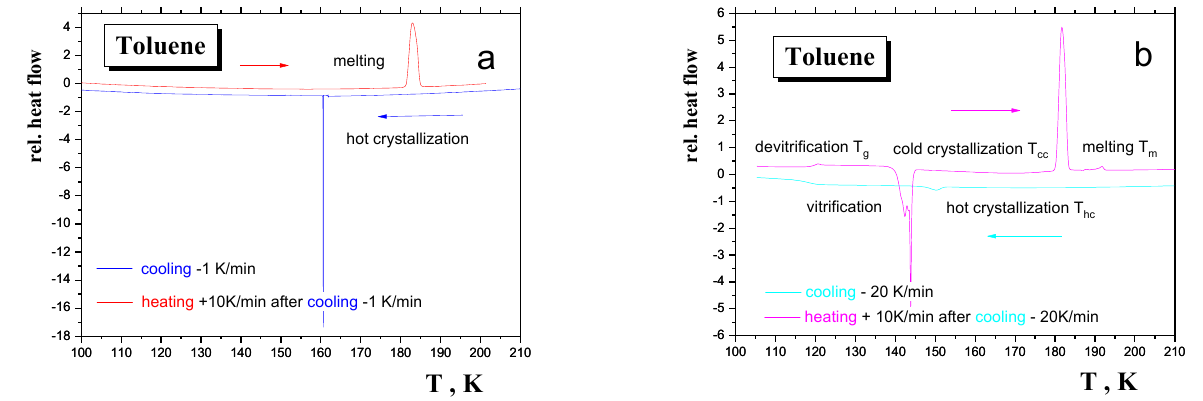
Figure 2. DSC thermograms for the TOL samples prepared using two distinct “boundary” formation